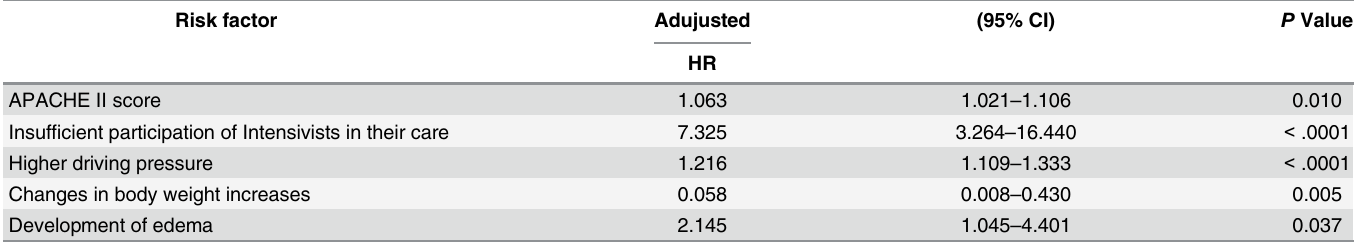
Table 4. Risk of ventilator-associated conditions: VAC using Cox proportional hazard model (Stepwise Variable Selection) (n = 303).